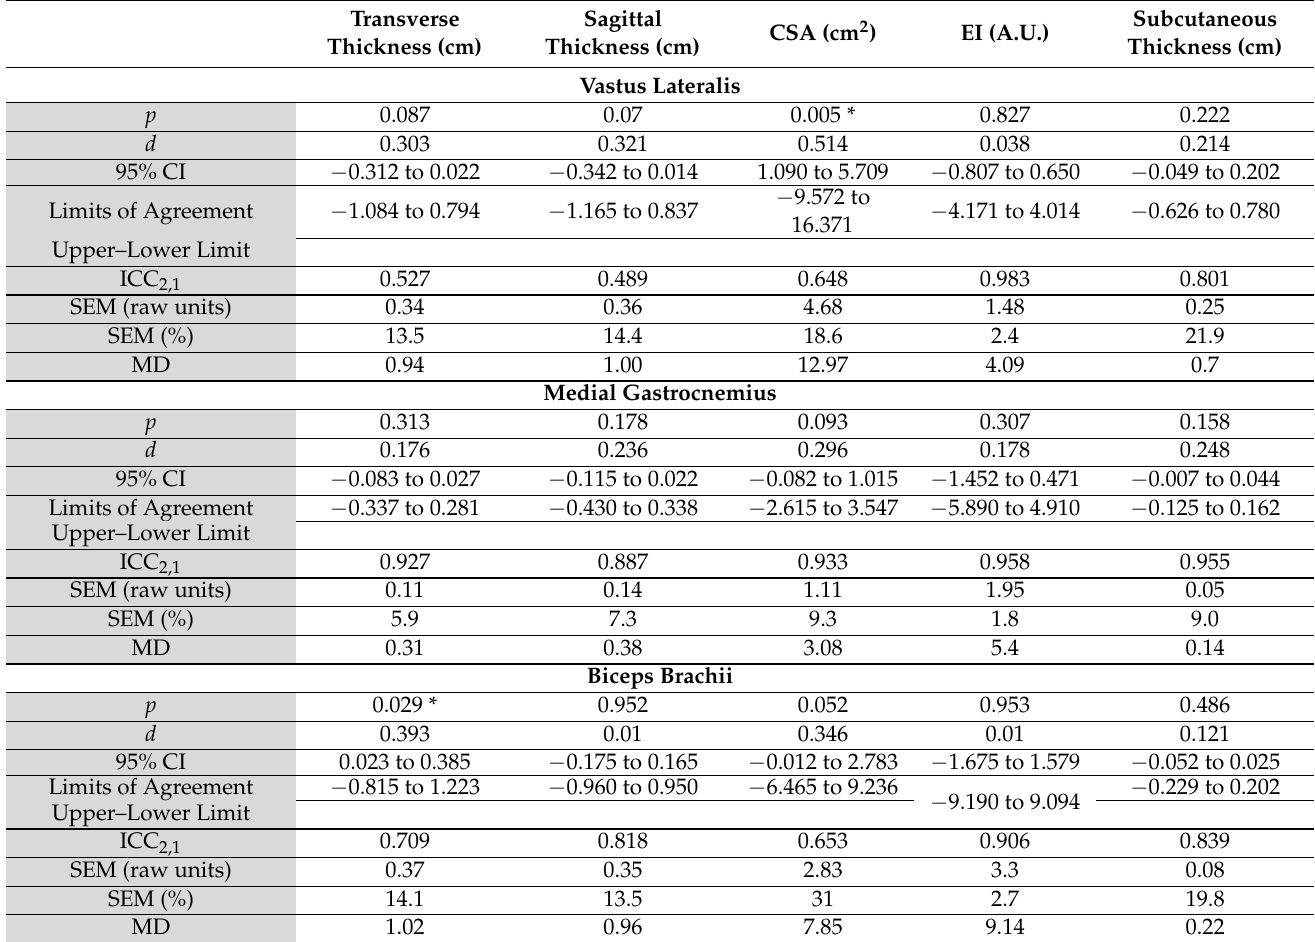
Table 4. Statistical outcomes for the image analysis comparisons between the experienced versus novice analysts. * = statistically significant difference between image